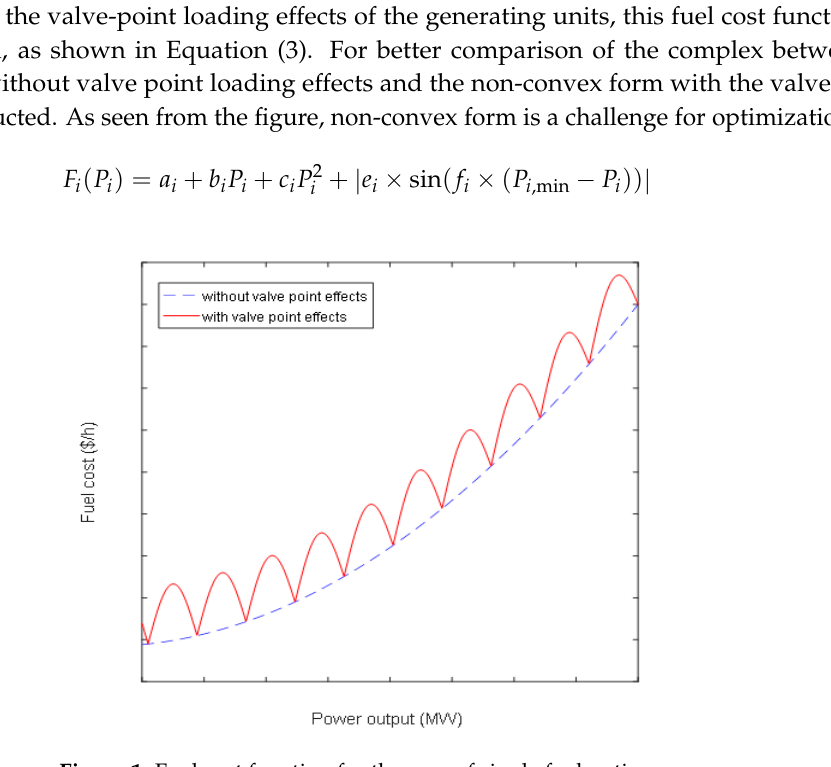
Figure 1. Fuel cost function for the case of single fuel option.